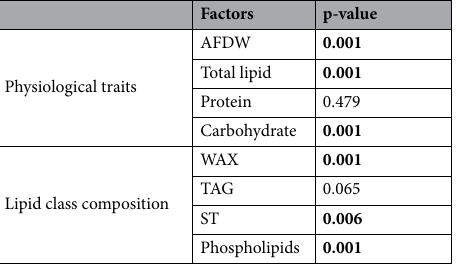
Table 4. Distance-based Redundancy Analysis (db-RDA) p-values of physiological traits and lipid class composition by factors measured. Significant p-values (p < 0.05) are in bold.